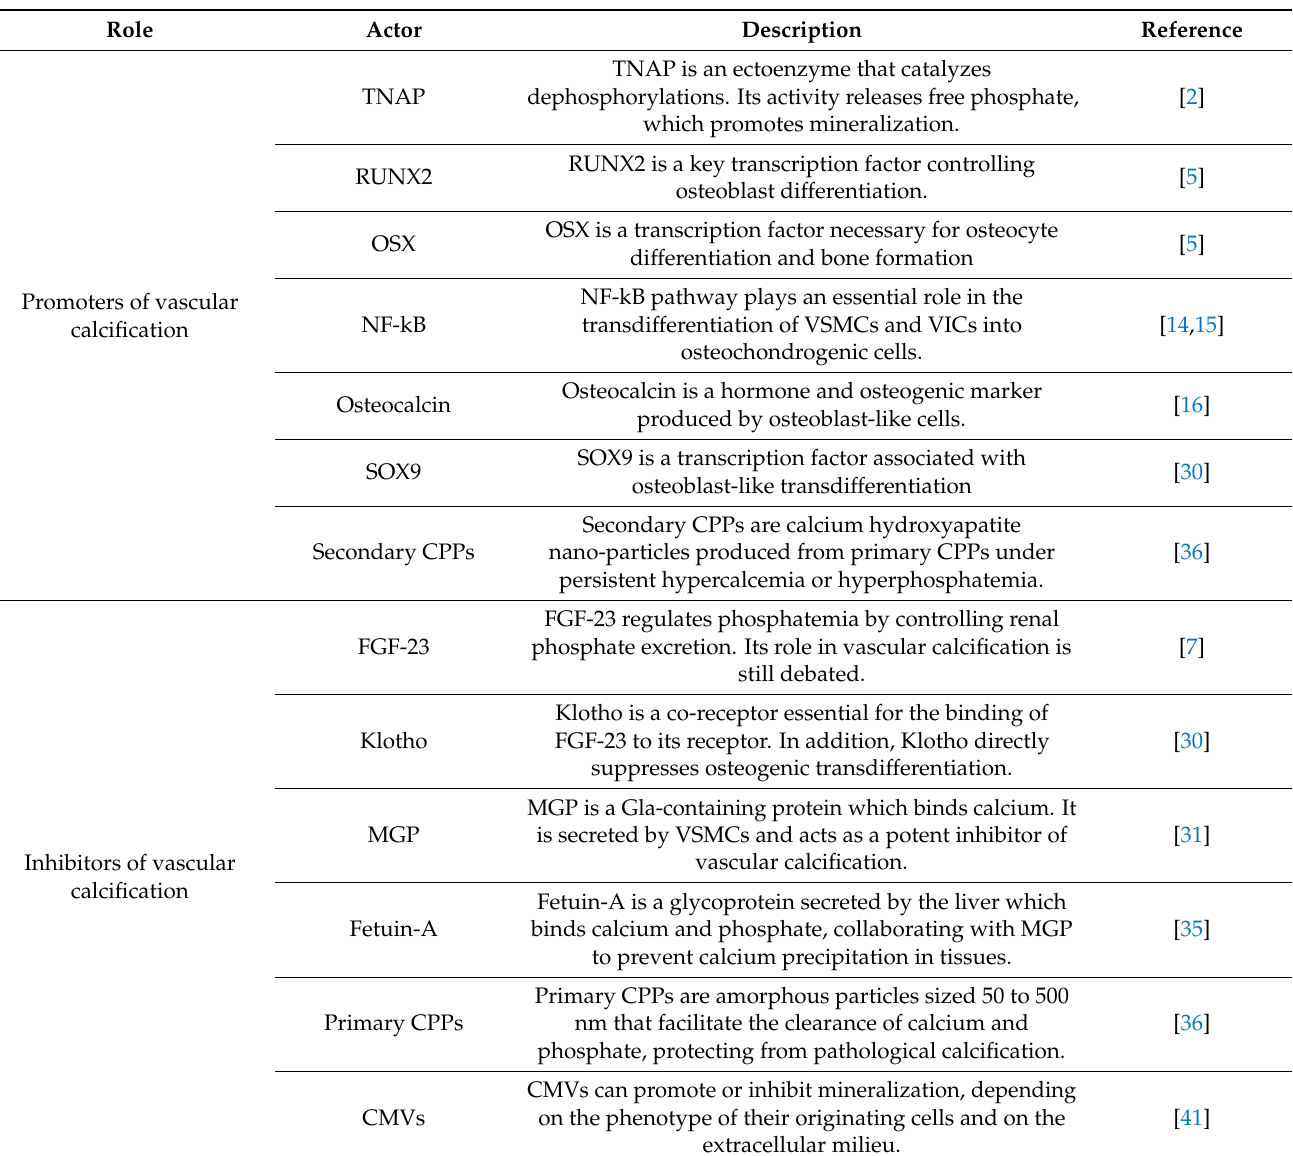
Table 2. Promoters and inhibitors of vascular calcification. CMVs = calcifying micro-vesicles; CPPs = calciprotein particles; FGF-23 = Fibroblast Growth Factor 23; MGP = Vitamin K-dependent matrix Gla- ( γ -carboxyglutamate) protein; NF-kB = Nuclear Factor- kappa B; OPN = Osteopontin; OSX = Osterix; RUNX2 = Runt-related transcription factor 2; SOX9 = ostheochondrocitic transcription factor; TNAP = tissue nonspecific alkaline phosphatase; VIC = Valve interstitial cell; VSMC = Vascular Smooth Muscle